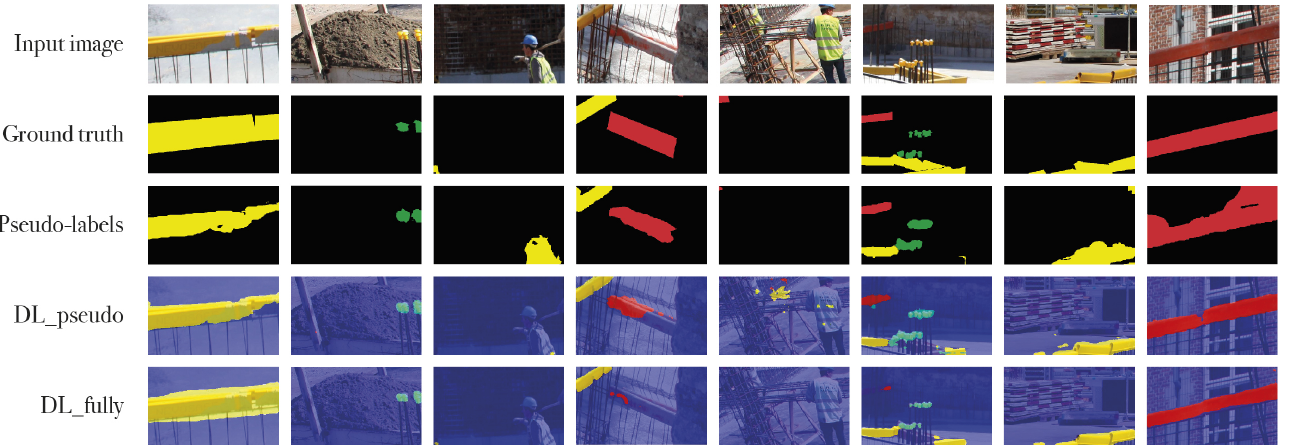
Figure 6. Qualitative results of IRNet. DL_pseudo is trained on the pseudo-labels generated by IRNet. DL_fully is trained on the ground truth